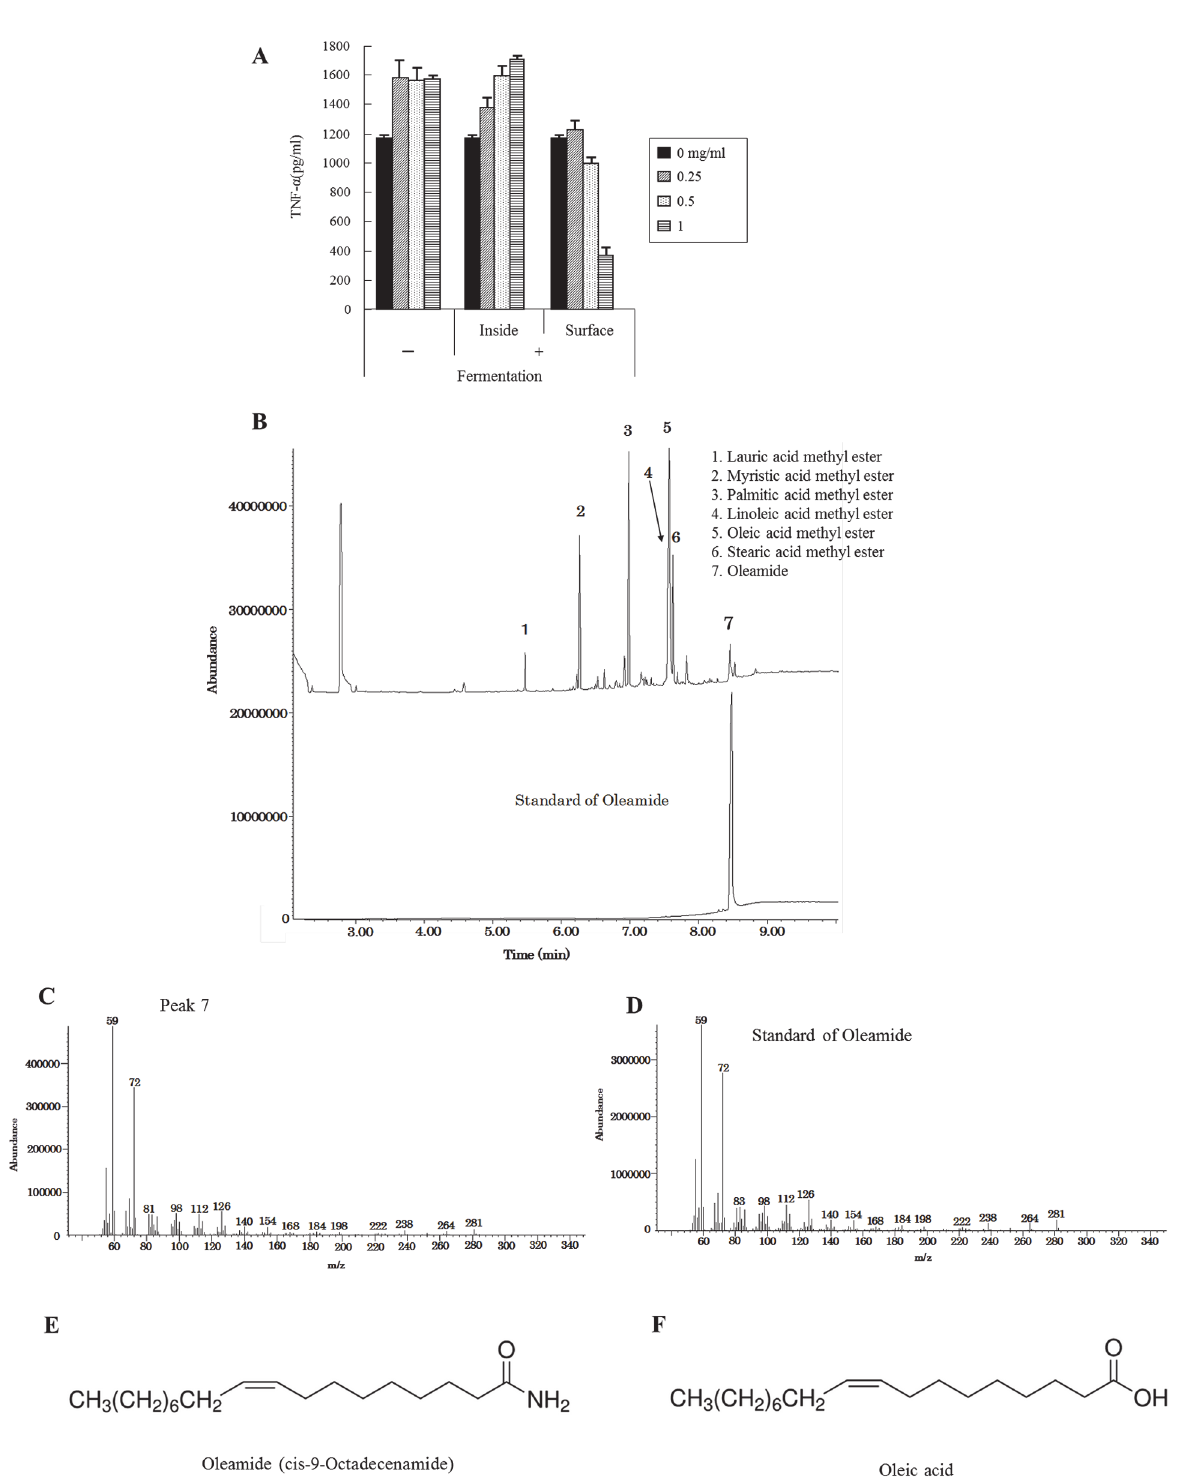
Fig 3. Lipid extraction and GC/MS analysis of extracts from the dairy product fermented with P. candidum . A , Isolated microglia were stimulated with 5 ng/ml of LPS and 0.5 ng/ml of IFN- γ after pretreatment with each methanol extract, and TNF- α production in the supernatant was quantified by ELISA. Error bars represent means ± SEM (n = the number of cheese samples) B , Chromatogram of the extract from the surface of the P . candidum -fermented product and oleamide as a standard. C and D , Mass spectra of Peak 7 and an oleamide standard, respectively. E and F , Chemical structural formula of oleamide and oleic acid,